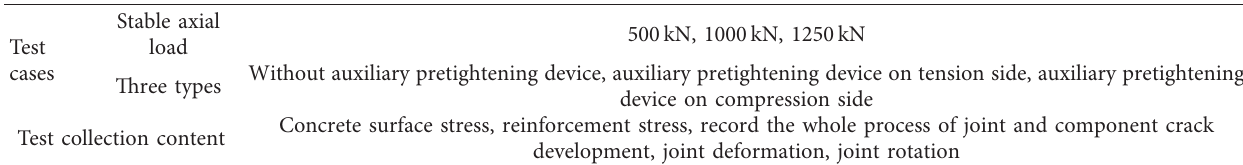
Figure 2: Arrangement and detail of double mortise-tenon Table 1: Test cases.